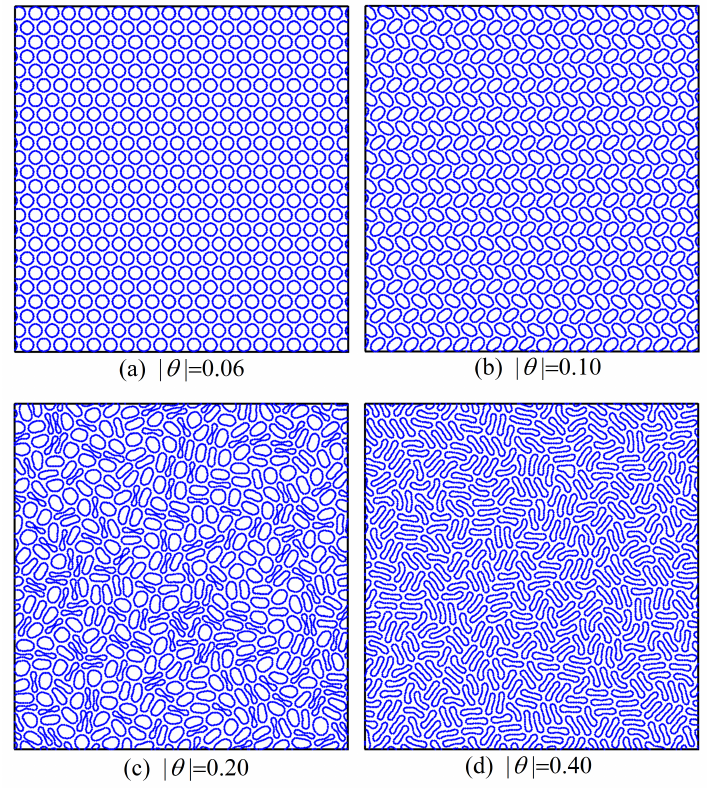
Figure 2. Structure of the CNT bundle shown for ( a – d ) | θ | = 0.06, 0.10, 0.20 and 0.40,